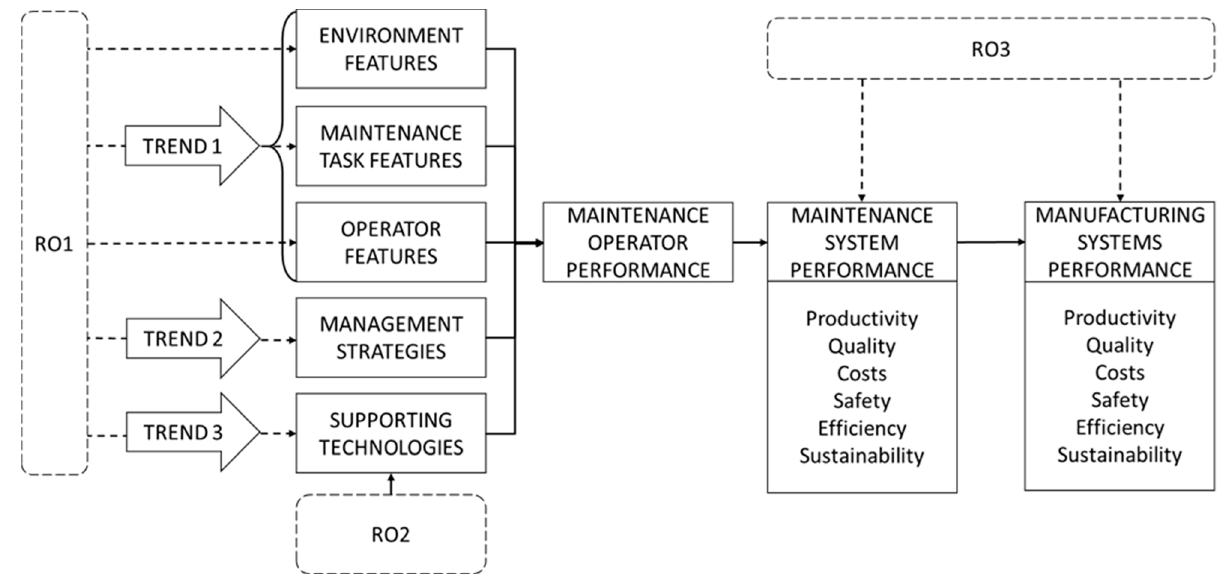
Figure 10. Research agenda.